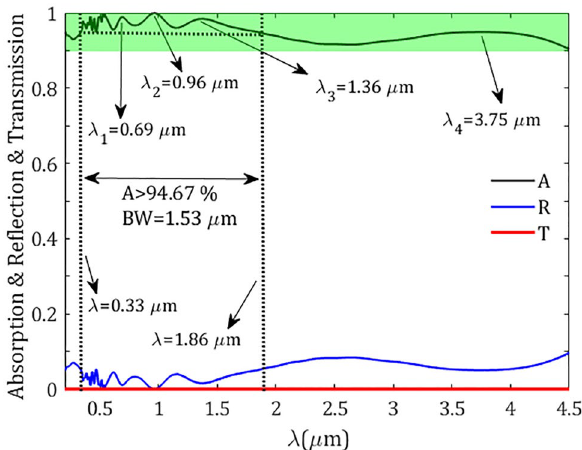
Figure 3. Absorption (A), reflection (R), and transmission (T) spectra of the proposed metasurface absorber in Fig. 1 under a normal incidence. The resonance wavelengths (cid:31) 1 − (cid:31) 4 , and absorption bands higher than 90 % (green band) and 94.67 % (dotted lines) in the wavelength range of study starting from 0.2 µm are indicated in the figure.